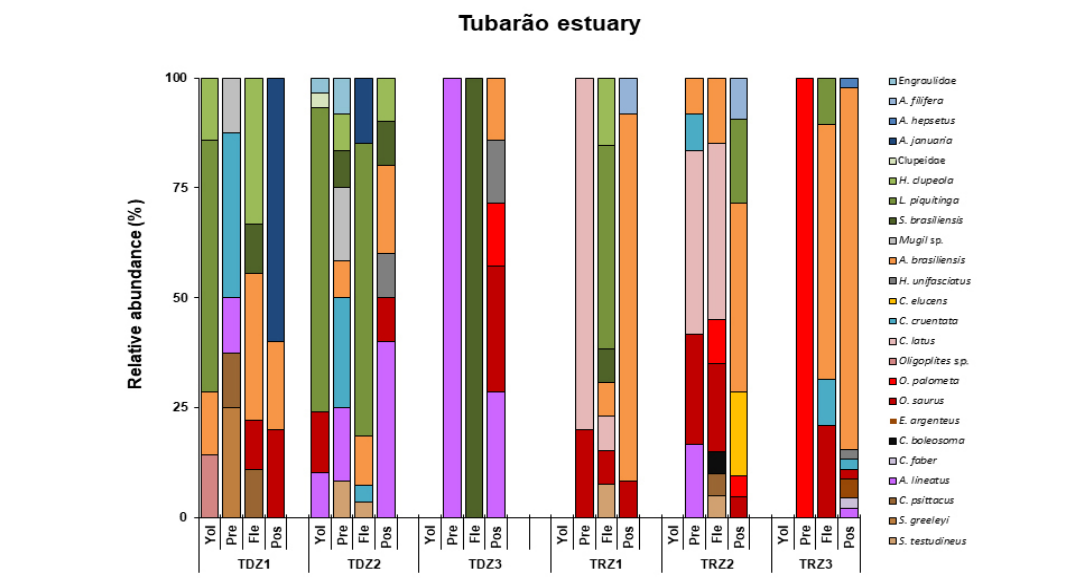
FIGURE 5 | Percentage contribution of species in Tubarão River estuary (Z1: Lower, Z2: Middle, Z3: Upper) in their periods of dry (TD) and rainy (TR). Yol = Vitelline larval; Pre = Pre-flexion; Fle = Flexion; Pos =